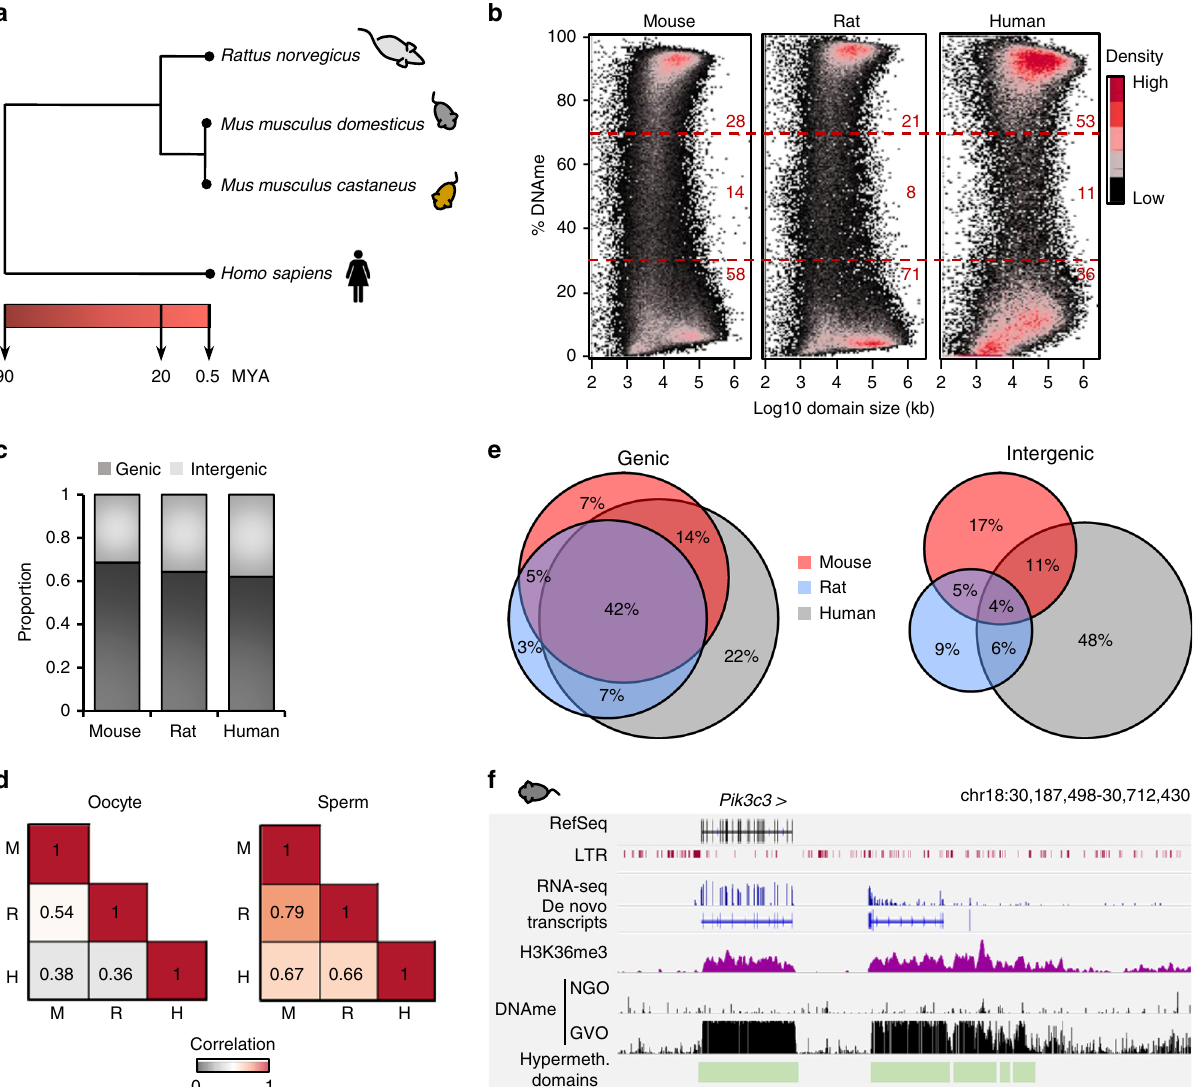
Fig. 1 Syntenic intergenic regions show divergent DNA methylation in rodent and human oocytes. a Evolutionary distance between rat, human, and the two mouse strains used in this study (adapted from http://timetreebeta.igem.temple.edu/). b Density plots depicting the distribution of DNAme in mouse, rat, or human oocytes. The percentage of each genome with low (<30%) or high (>70%) DNAme is indicated in red. DNAme domains were identi fi ed using Changepoint analysis. c Proportion of hypermethylated (>70% DNAme) genome-wide 1 kb bins in genic or intergenic regions. Total number of bins with suf fi cient coverage: mouse: 934,621 genic/1,132,257 intergenic; rat: 794,069 genic/1,195,429 intergenic; human: 1,024,005 genic/1,132,257 intergenic. d Heat map of the correlation between DNAme patterns in oocytes or sperm over 433,111 syntenic genomic regions (1 kb bins with >5× coverage over >5 CpGs in all 3 species). e Venn diagrams showing the overlap in hypermethylated (>70% DNAme) syntenic genomic regions (1 kb bins). Methylated bins in syntenic intergenic regions are more divergent than those overlapping an annotated gene (mm10, rn6, or hg19 Ensembl annotation) in all three species. f Genome browser screenshot of the Pik3c3 locus in mouse oocytes. Note the presence of de novo DNAme and H3K36me3 coincident with the predicted intergenic transcription units. Mouse and human WGBS datasets (described in the data summary table) are from refs.